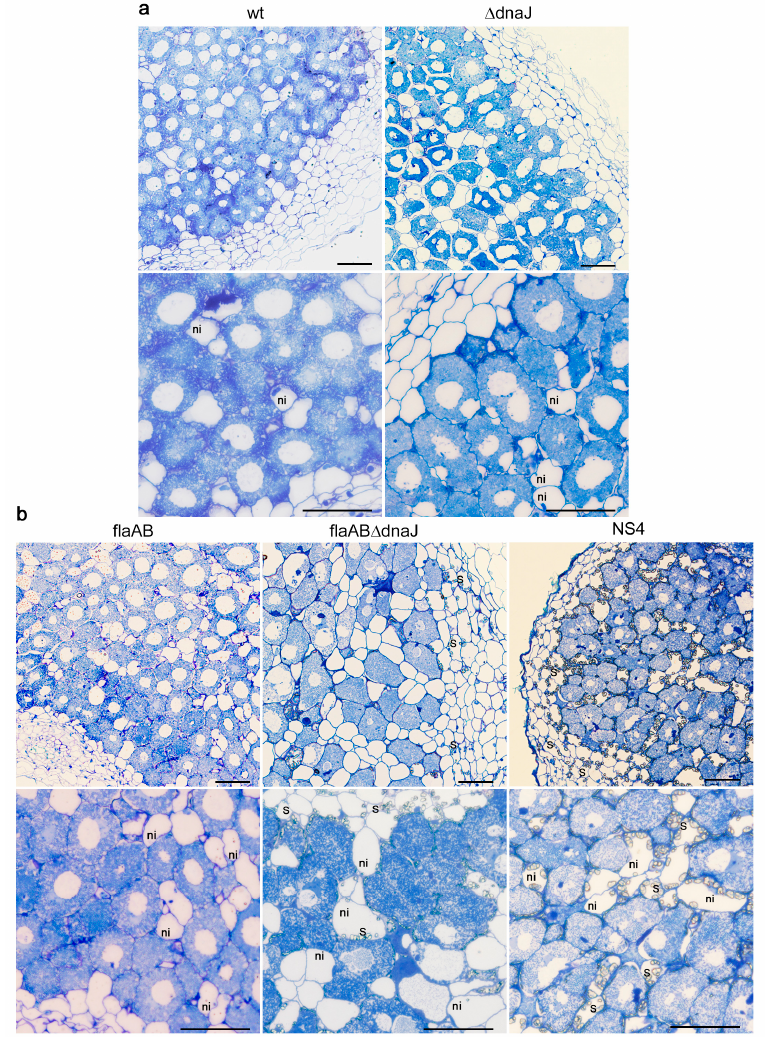
Figure 9. Light micrographs of sections of alfalfa nodules elicited by ( a ) GR4 strain (wt) and its derivative dnaJ deletion mutant ( Δ dnaJ), and ( b ) GR4 fl aAB ( fl aAB), its dnaJ deletion mutant ( fl aAB Δ dnaJ), and the NS4 transposant. Bars correspond to 50 µm. ni, noninfected cells; s, starch granules. The results revealed that the dnaJ mutant strains were able to colonize the nodule cells and di ff erentiate into bacteroids. However, nodules elicited by the mutants appeared to contain fewer infected cells than the nodules induced by the parental strains (Figure 9). To con fi rm this observation, the number of infected and noninfected cells was determined. The percent of noninfected cells in sections of nodules induced by GR4 and GR4 fl aAB was similar (14.6% ± 3.7% vs. 17.6% ± 3.3%; p = 0.6). In contrast, the number of noninfected cells in nodules induced by the GR4 derivative dnaJ mutant was 2.1 times higher than that of GR4 (30.7% ± 1.9% vs. 14.6% ± 3.7%; p = 0.005). Notably, nodules induced by fl aAB Δ dnaJ